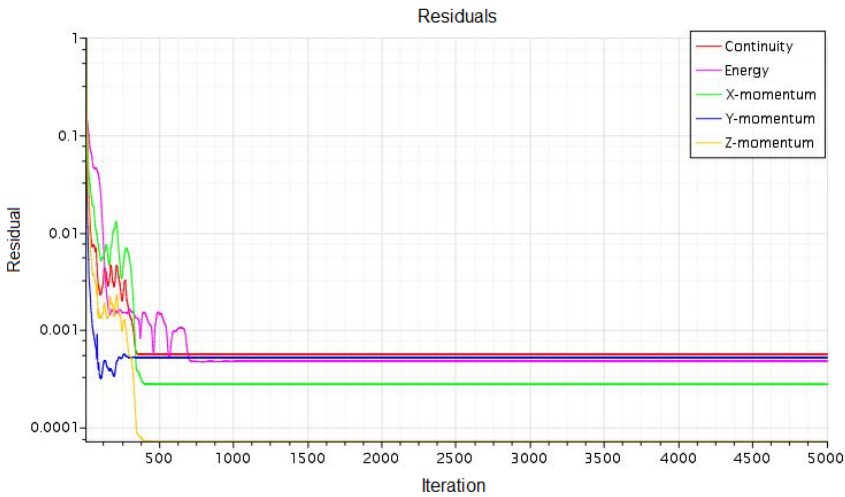
Figure 7. Variation in the residual fraction of the